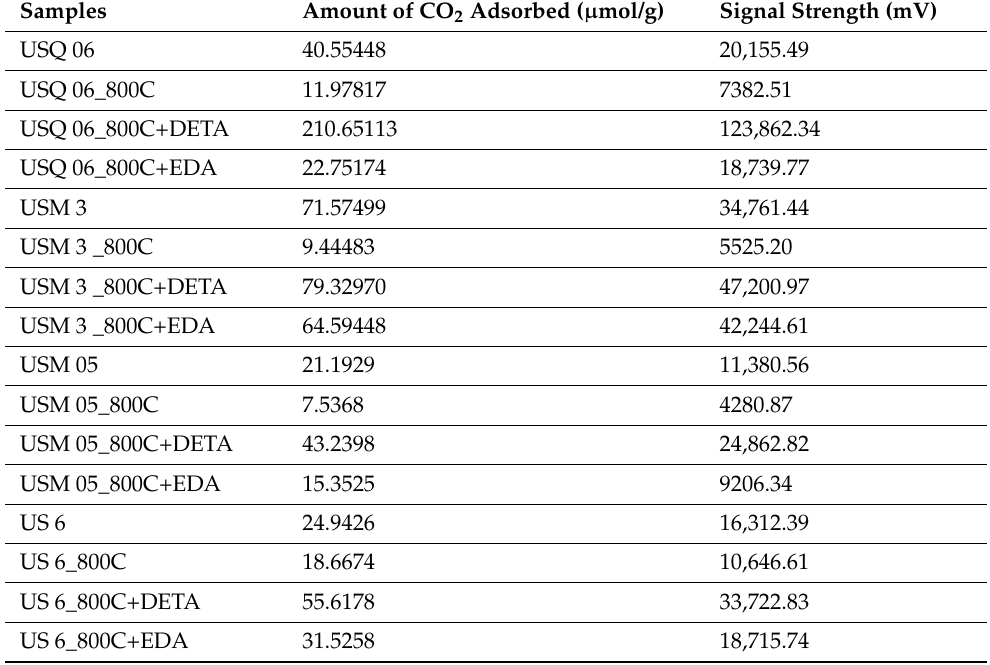
Table 3. Variations in the amount of CO 2 sorbed and its corresponding signal strength with pyrolysis and amine